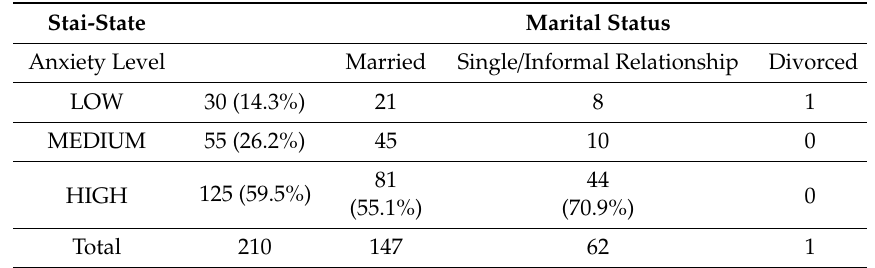
Table 4. The correlation between marital status and anxiety levels based on STAI-STATE subscale. p = 0.0222.